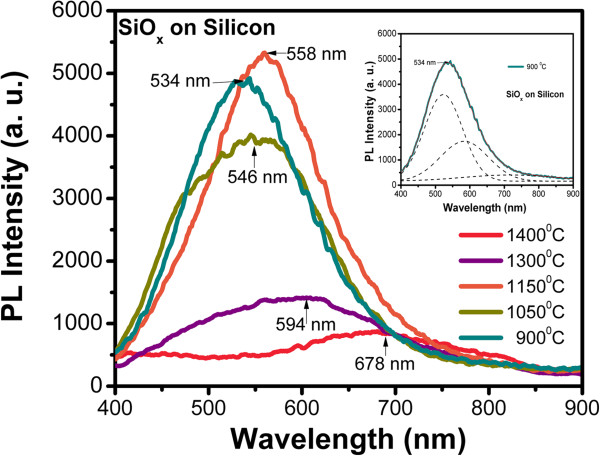
PL spectra of the SiOxfilms with different Tg. Inset shows the convolution realized to PL spectra.